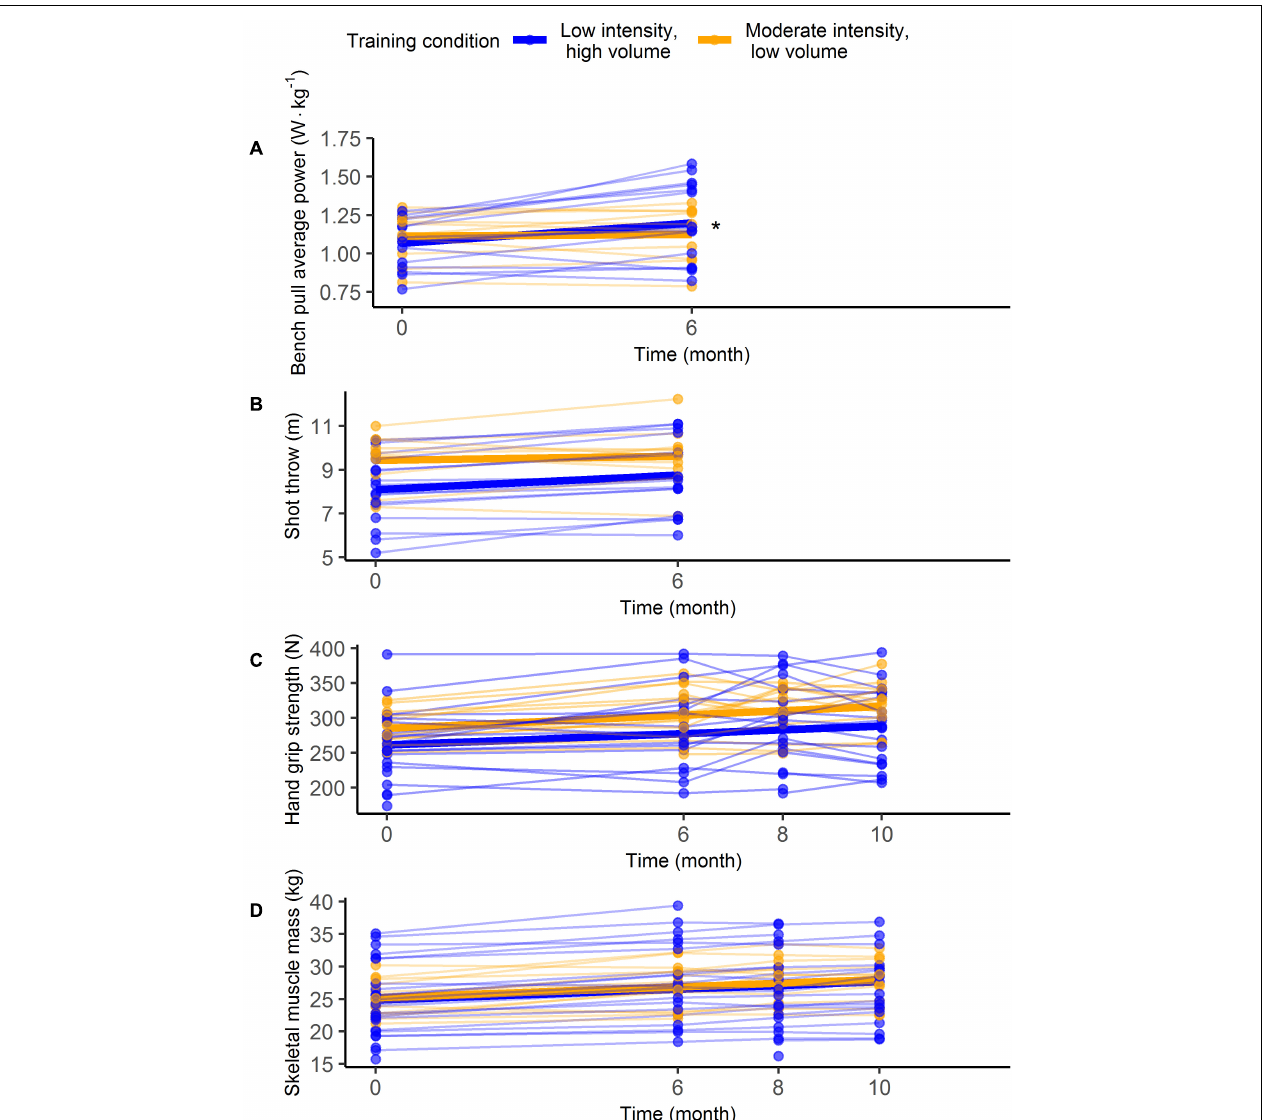
FIGURE 2 | Individual data (thin lines) and model estimates (thick lines) of the between-subject analyses for the outcomes bench pull average power (A) , shot throw (B) , hand grip strength (C) , and skeletal muscle mass (D) . Asterisks (*) flag significant interactions.